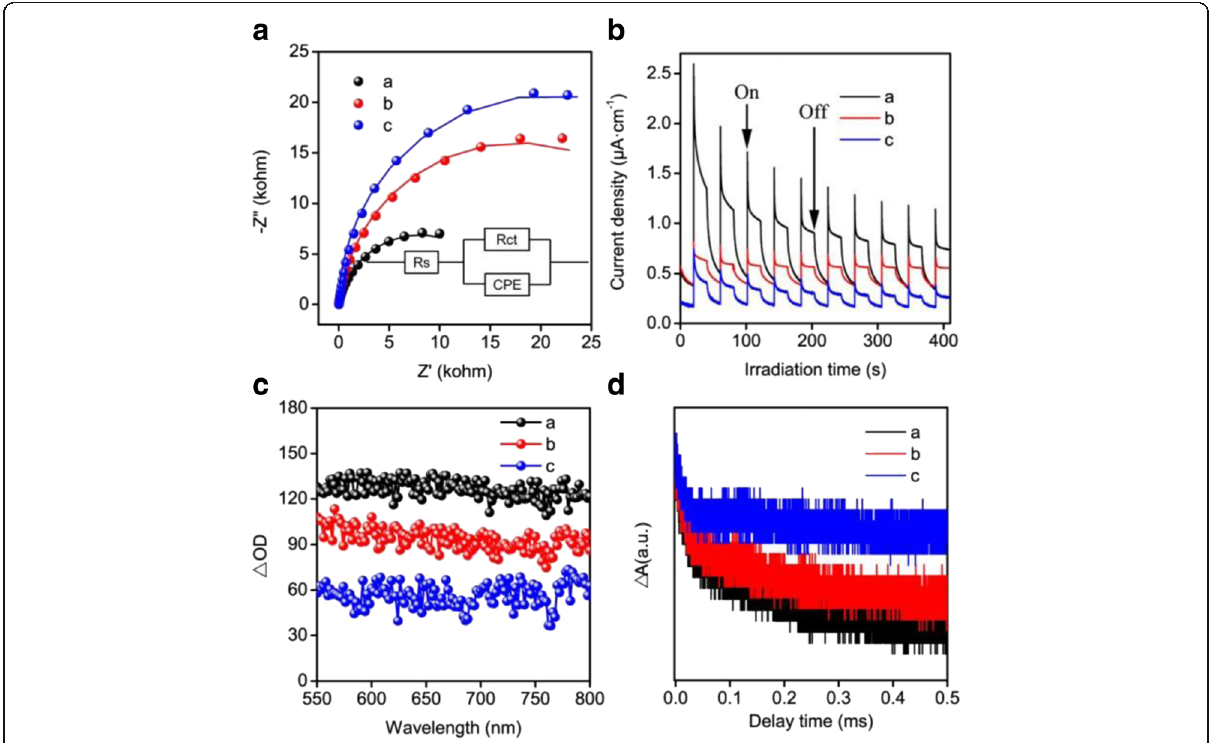
Fig. 6 EIS Nyquist plots of a (SnNb 2 O 6 ), b (the mixed phases of SnNb 2 O 6 and Sn 2 Nb 2 O 7 ), and c (Sn 2 Nb 2 O 7 ) samples ( a ). Comparison of transient photocurrent response of the samples with light on/off cycles under white (neutral) light irradiation (LED 690 lm, [Na 2 SO 4 ] = 0.2 M) ( b ). Transient absorption spectra measured at a delay time of 0.3 ms ( c ). Transient absorption decay kinetics of the prepared samples at an